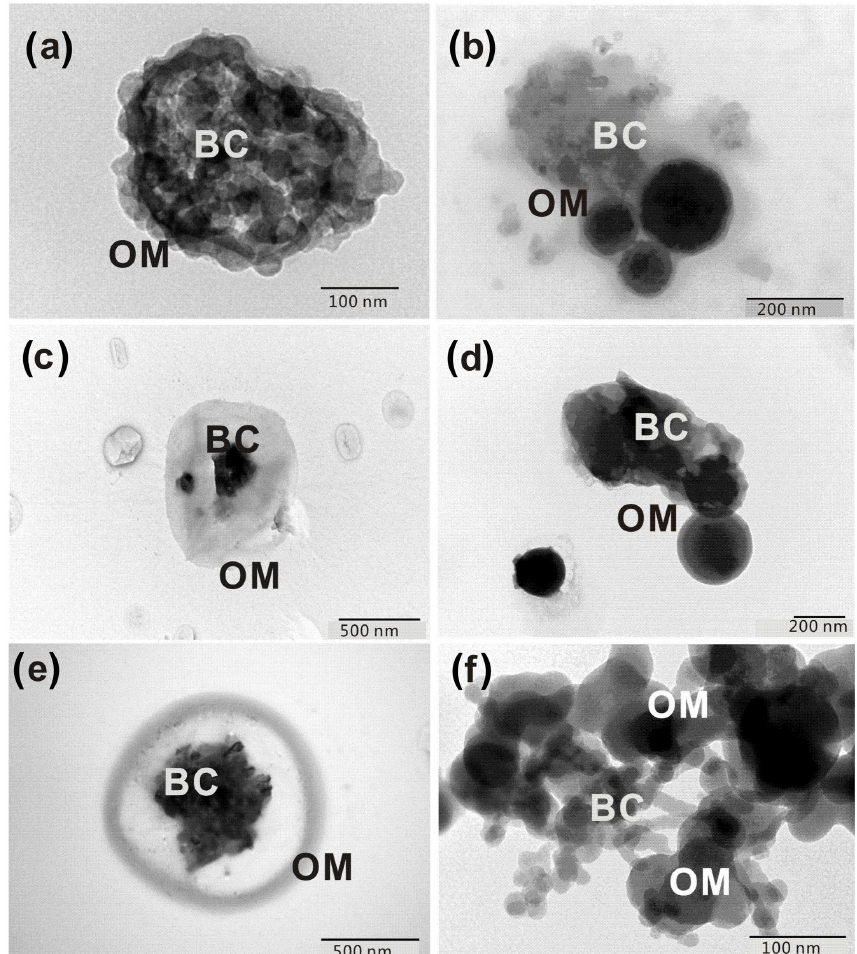
Figure 8. Internal mixing states of BC (soot) and OM in glacier–snowpack in the northeastern Tibetan Plateau in summer